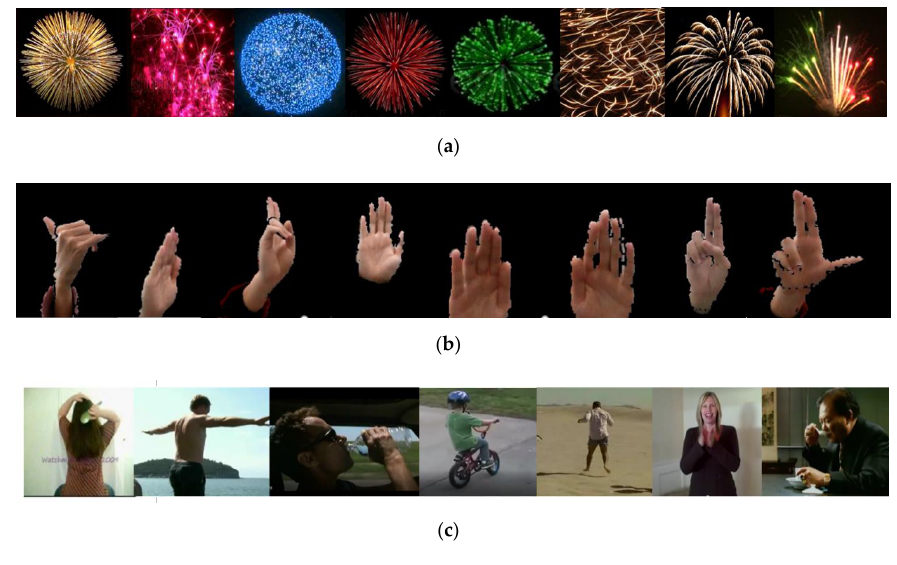
Figure 3. Sample video frames of datasets. ( a ) Fireworks dataset; ( b ) Hand gestures dataset; ( c ) HMDB51 dataset. ( c ) HMDB51